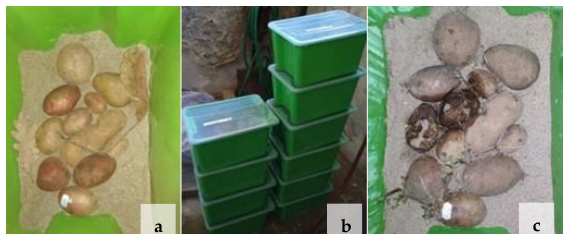
Figure 7. Experimental setup with large boxes to investigate the role of Armadillidium vulgare on Fusarium solani infection of stored potato in Gödöllő, Hungary 2018. a) Tubers in a box at the begin- Fusarium solani infection of stored potato in Gödöll˝o, Hungary 2018. ( a ) Tubers in a box at the ning of the experiment. b) Arrangement of boxes in one of the three involved storage cellars. c) Tubers in a box at the termination of the experiment. The artificially infected tuber is marked with beginning of the experiment. ( b ) Arrangement of boxes in one of the three involved storage cellars. white. A. vulgare individuals were introduced to every second box. (Photo: Nóra Plangár). ( c ) Tubers in a box at the termination of the experiment. The artificially in-fected tuber is marked with white. A. vulgare individuals were introduced to every sec-ond box. (Photo: N ó ra Plang á